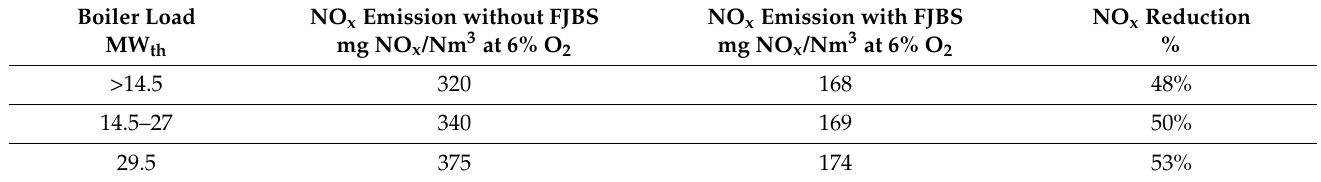
Table 1. Average NO x emissions and reductions during non-catalytic FJBS